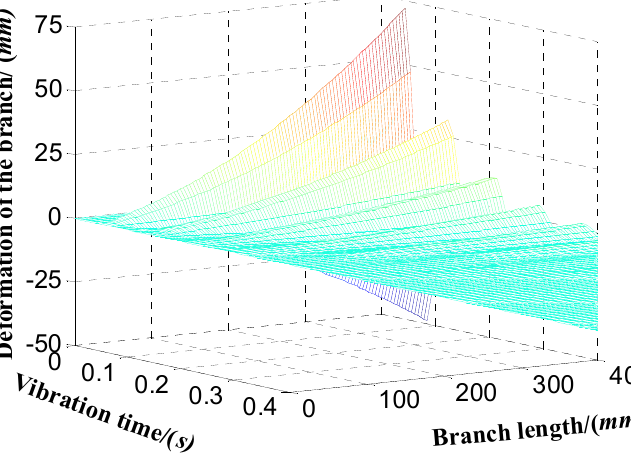
Figure 11. Deformation surface for the blueberry branch.